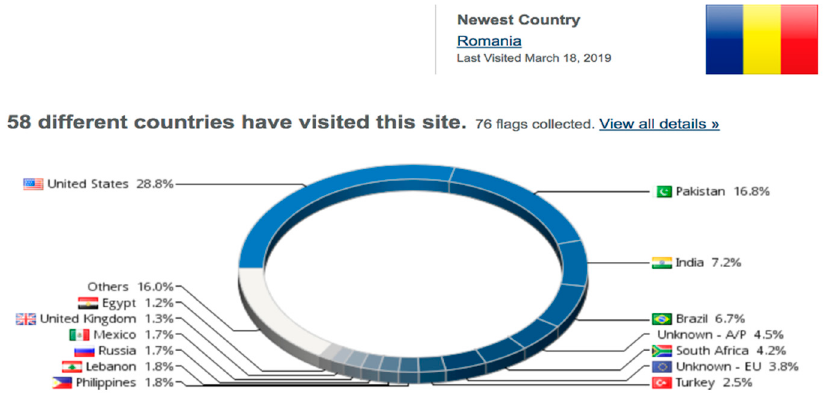
Figure 9. Account 1’s total countries and privacy policy visitors.